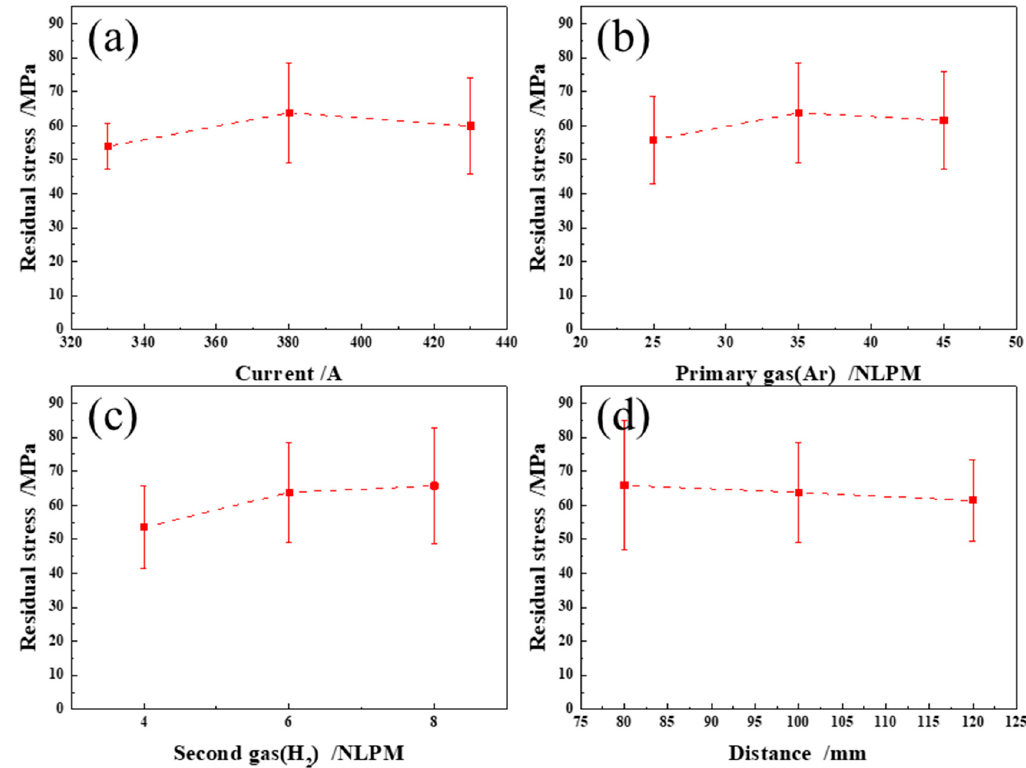
Figure 6. Residual stress variation with differences in ( a ) current, ( b ) primary gas, ( c ) second gas, and ( d ) spraying distance.